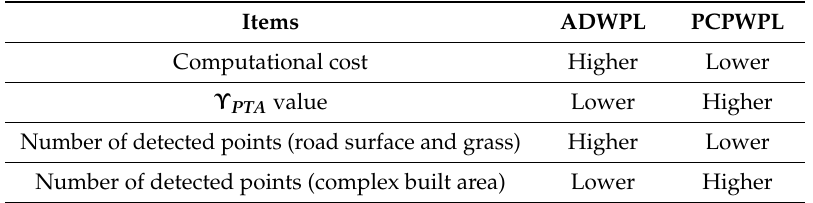
Table 2. Performance comparison between ADWPL and PCPWPL in the HKIA case.